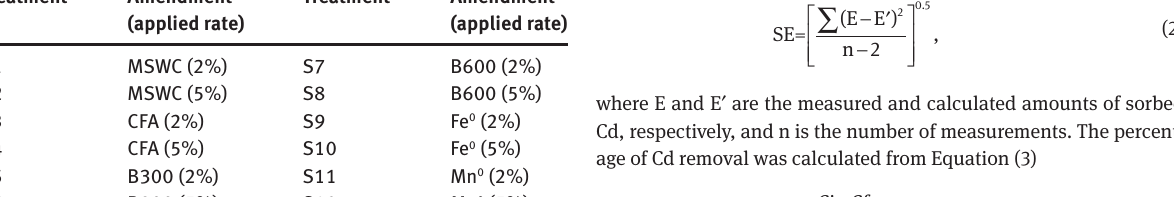
Table 3: Description of treatments for incubation treatment. Treatment